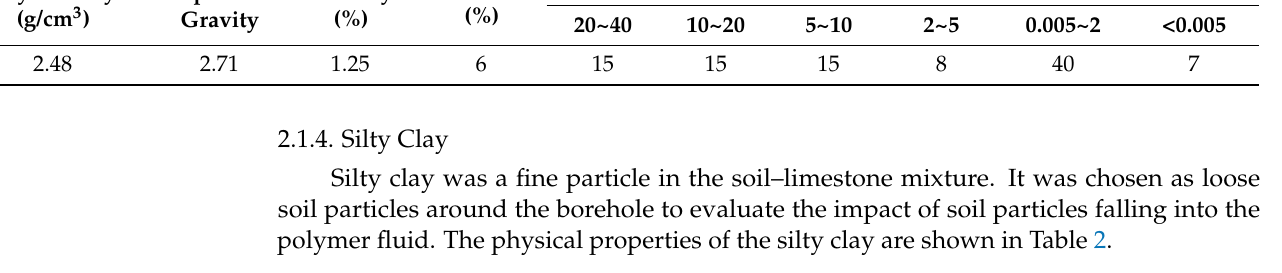
Table 2. Physical properties of the silty